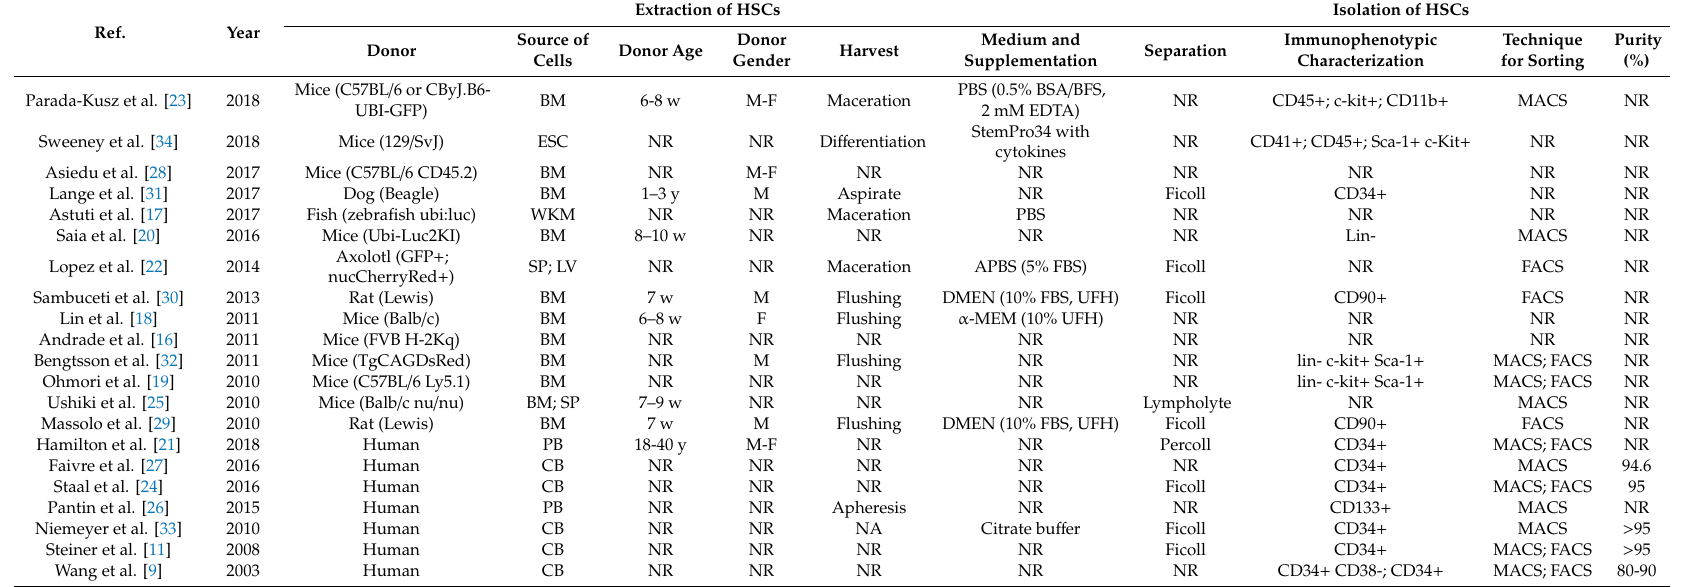
Table 1. Extraction and isolation of hematopoietic stem